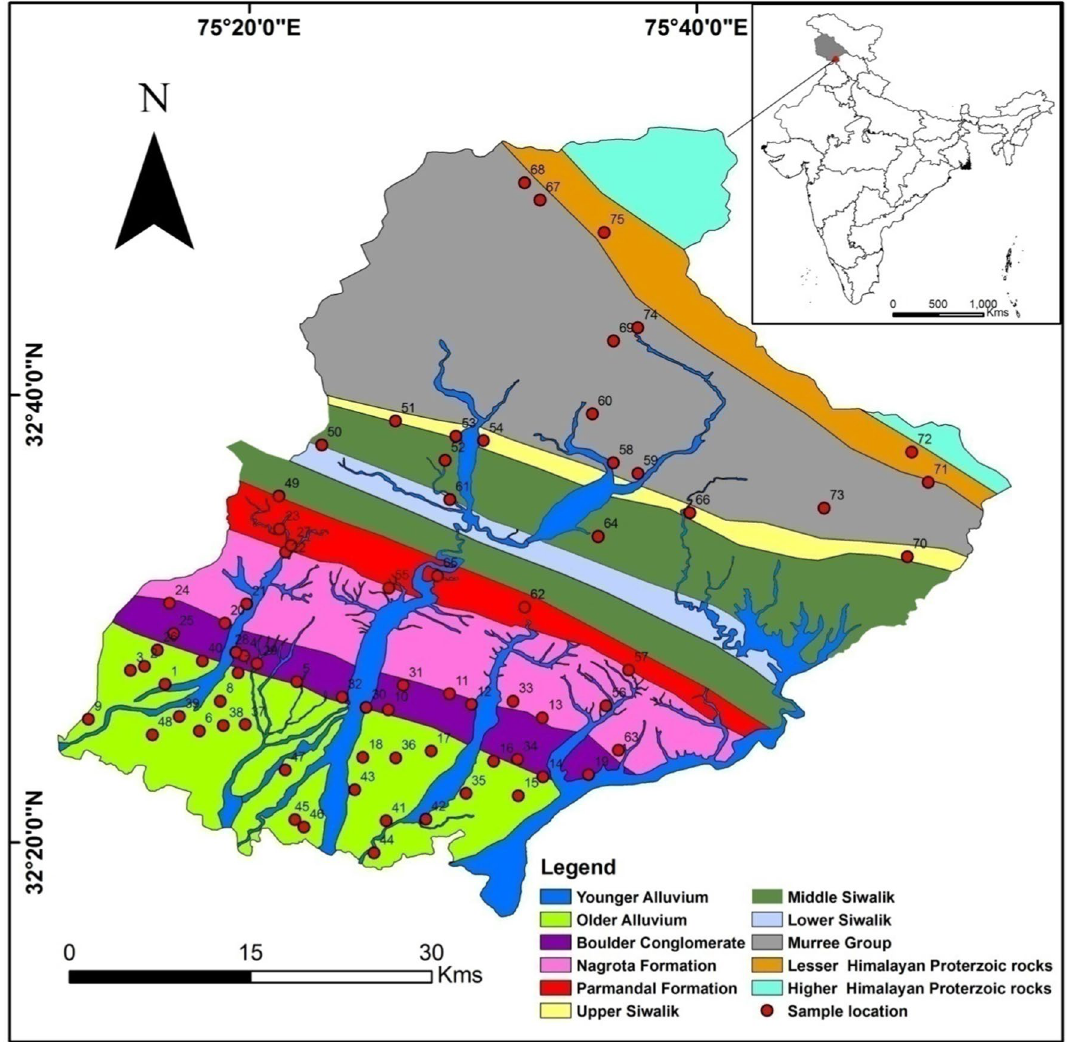
Fig. 1 Geological map of the study area showing the location of the groundwater samples. Inset is the map of India showing study area, high‑ lighted by red color (redrawn and modified after Karunakaran and Ranga Rao